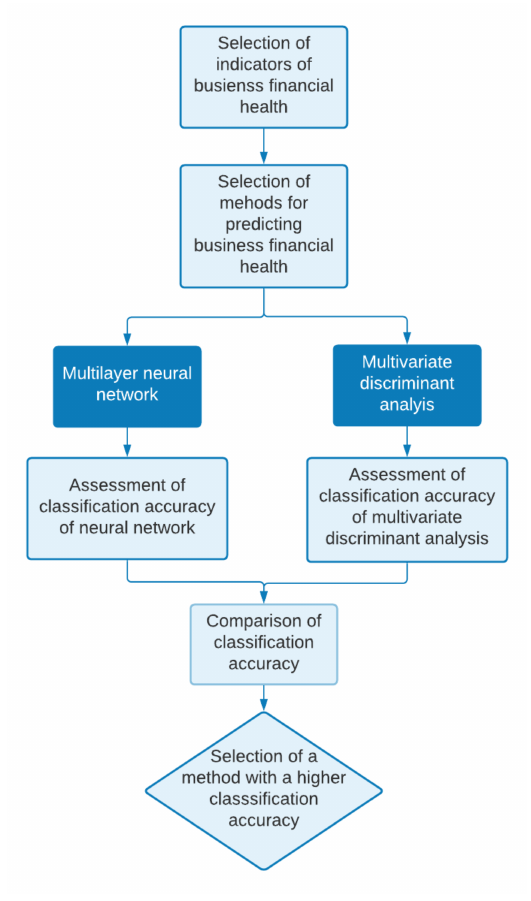
Figure 1. Flowchart of the research. Source: